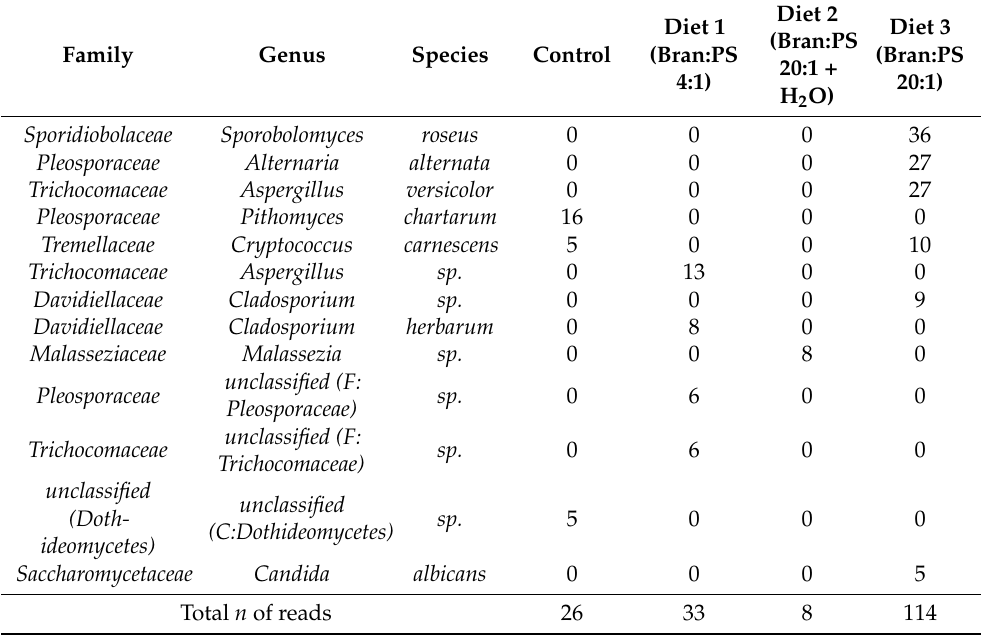
Table 2. Identified fungi counts in the digestive tracts of T. molitor after degrading PS following different feeding